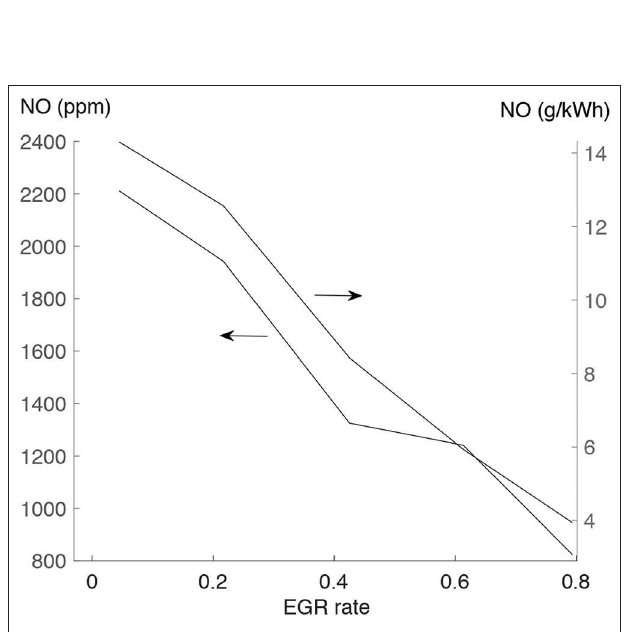
FIGURE 21 | A factor three in NO reduction can be achieved thanks to EGAR, for early combustion timings and prior to the N 2 O threshold (set #7, constant